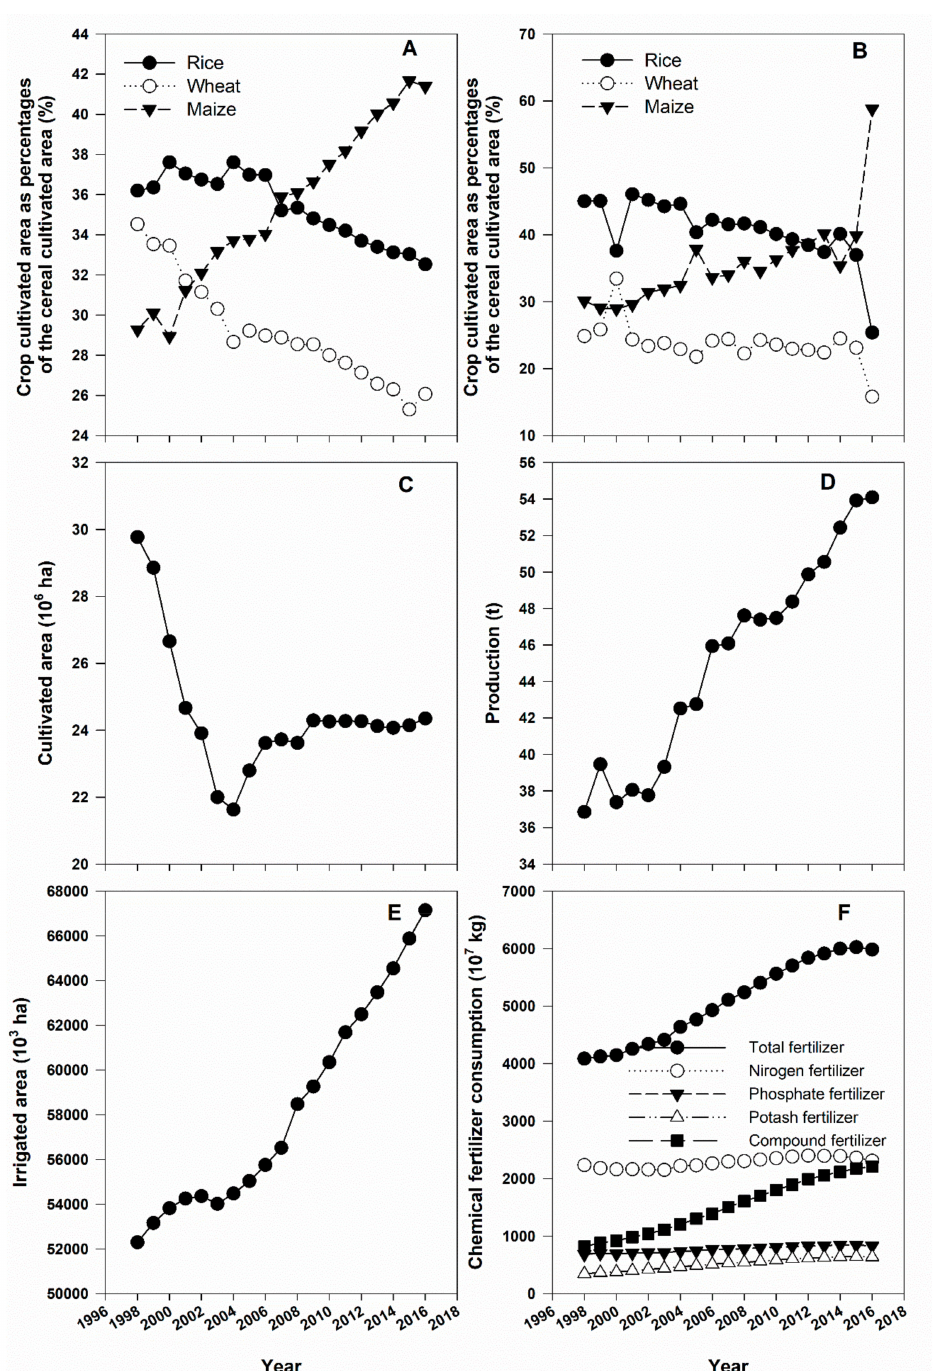
Figure 7. The variation in rice, wheat, and maize cultivated area ( A ) and production ( B ) as percentages of the cereal cultivated area or production, soybeans cultivated area ( C ) and production ( D ), irrigated area ( E ), and nitrogen, phosphate, potash, and compound fertilizer consumption, as well as total fertilizer consumption ( F ) in China from 1998 to